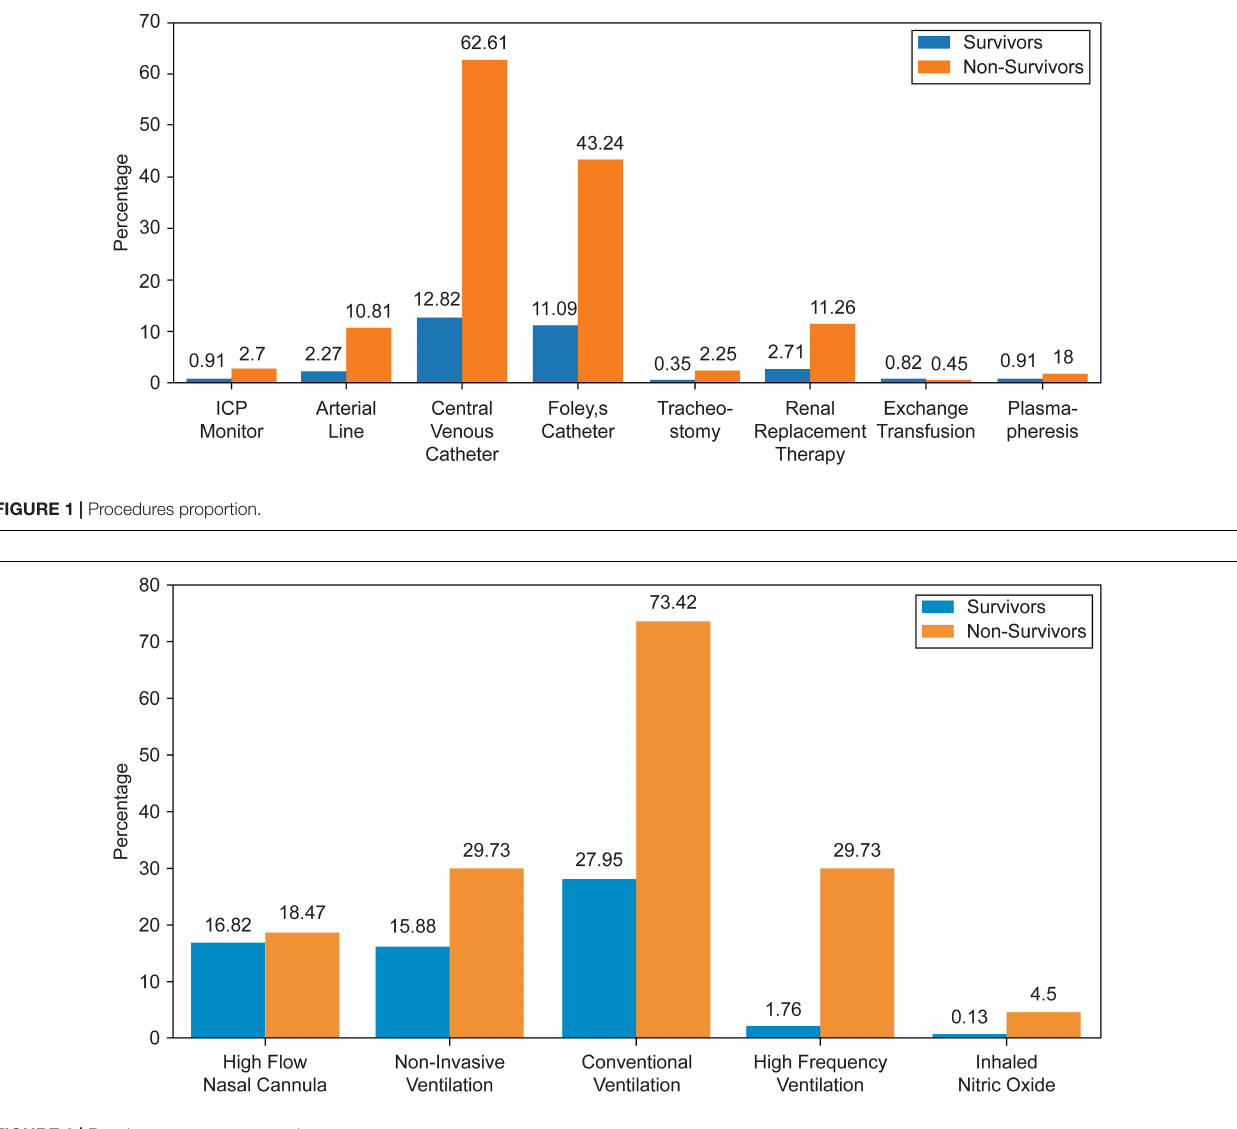
FIGURE 2 | Respiratory support